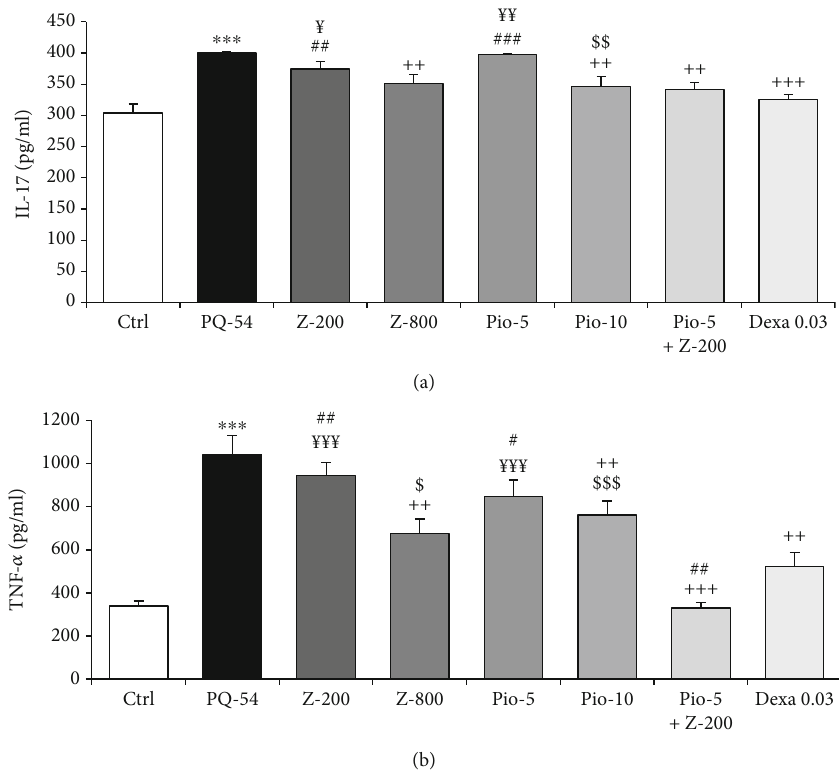
Figure 6: Values of IL-17 (a), INF- α (b) in serum of control group (Ctrl), group exposed to paraquat aerosol at doses of 54mg/m 3 (PQ-54), groups exposed to PQ-54mg/m 3 and treated with 5 and 10 mg/kg/day pioglitazone, 200 and 800mg/kg/day Zataria multi fl ora , 0.03mg/kg/day dexamethasone, and 5 mg/kg/day pioglitazone + 200mg/kg/day Zataria multif lora (Pio-5, Pio-10, Z-200, Z-800, Dexa 0.03, and Pio ‐ 5 + Z ‐ 200 , respectively). The results are expressed as the mean ± SEM ( n = 6 in each group). ∗∗∗ p < 0 : 001 compared to the control group. ++ p < 0 : 01 and +++ p < 0 : 001 compared to the PQ group. # p < 0 : 05 , ## p < 0 : 01 , and ### p < 0 : 001 compared dexamethasone treatment with other treated groups. $ p < 0 : 05 , $$ p < 0 : 01 , and $$$ p < 0 : 001 compared to low dose of Zataria multi fl ora and pioglitazone groups. ¥ p < 0 : 05 and ¥¥¥ p < 0 : 001 compared to Pio ‐ 5mg/kg + Z ‐ 200mg/kg group. Comparisons between di ff erent groups were made using one-way ANOVA followed by Tukey ’ s multiple comparison